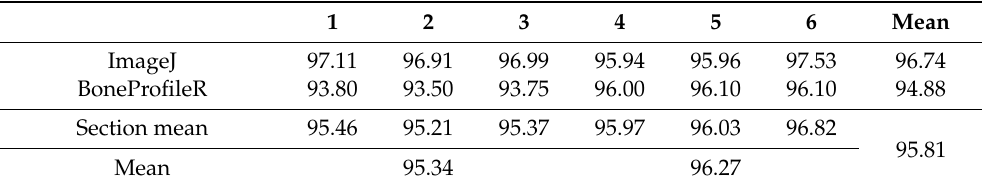
Table 2. Vertebral compactness, expressed as percentages (%), measured in three transversal (1, 2, 3) and three longitudinal (4, 5, 6) sections of ALG 200, holotype of Carentonosaurus algorensis sp. nov., from the uppermost middle to lowermost upper Cenomanian site of Algora (Guadalajara Province, Central